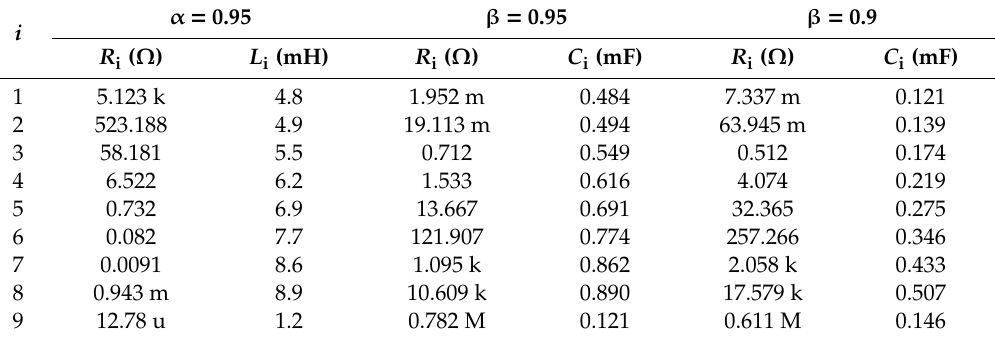
Table 1. The circuit parameters of the fractional-order inductor and